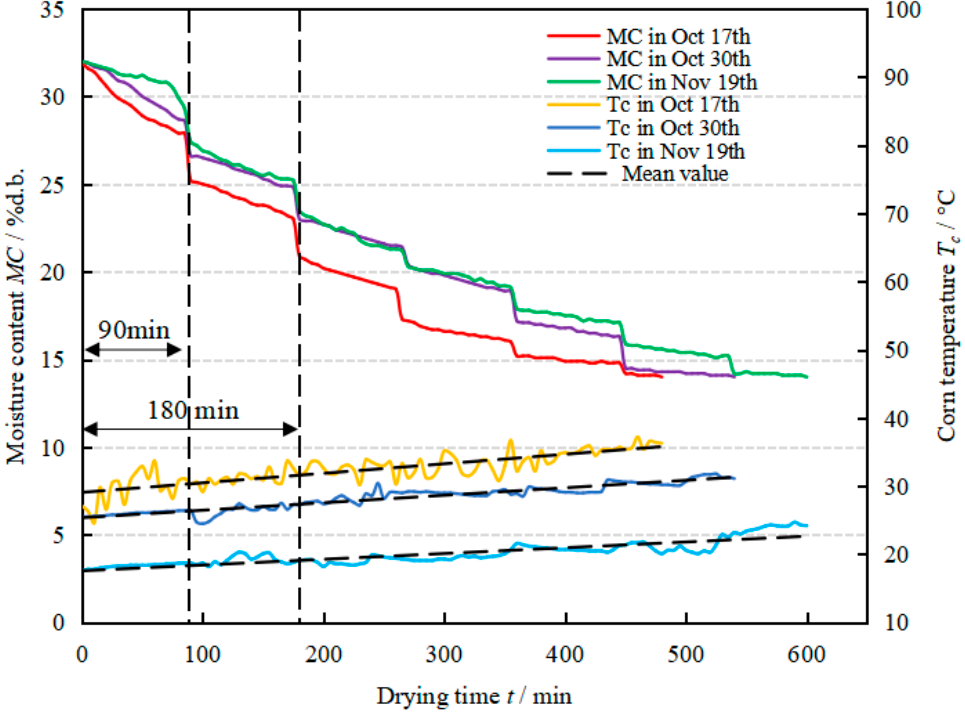
Figure 5. The variations of corn moisture content and corn temperature with drying time.